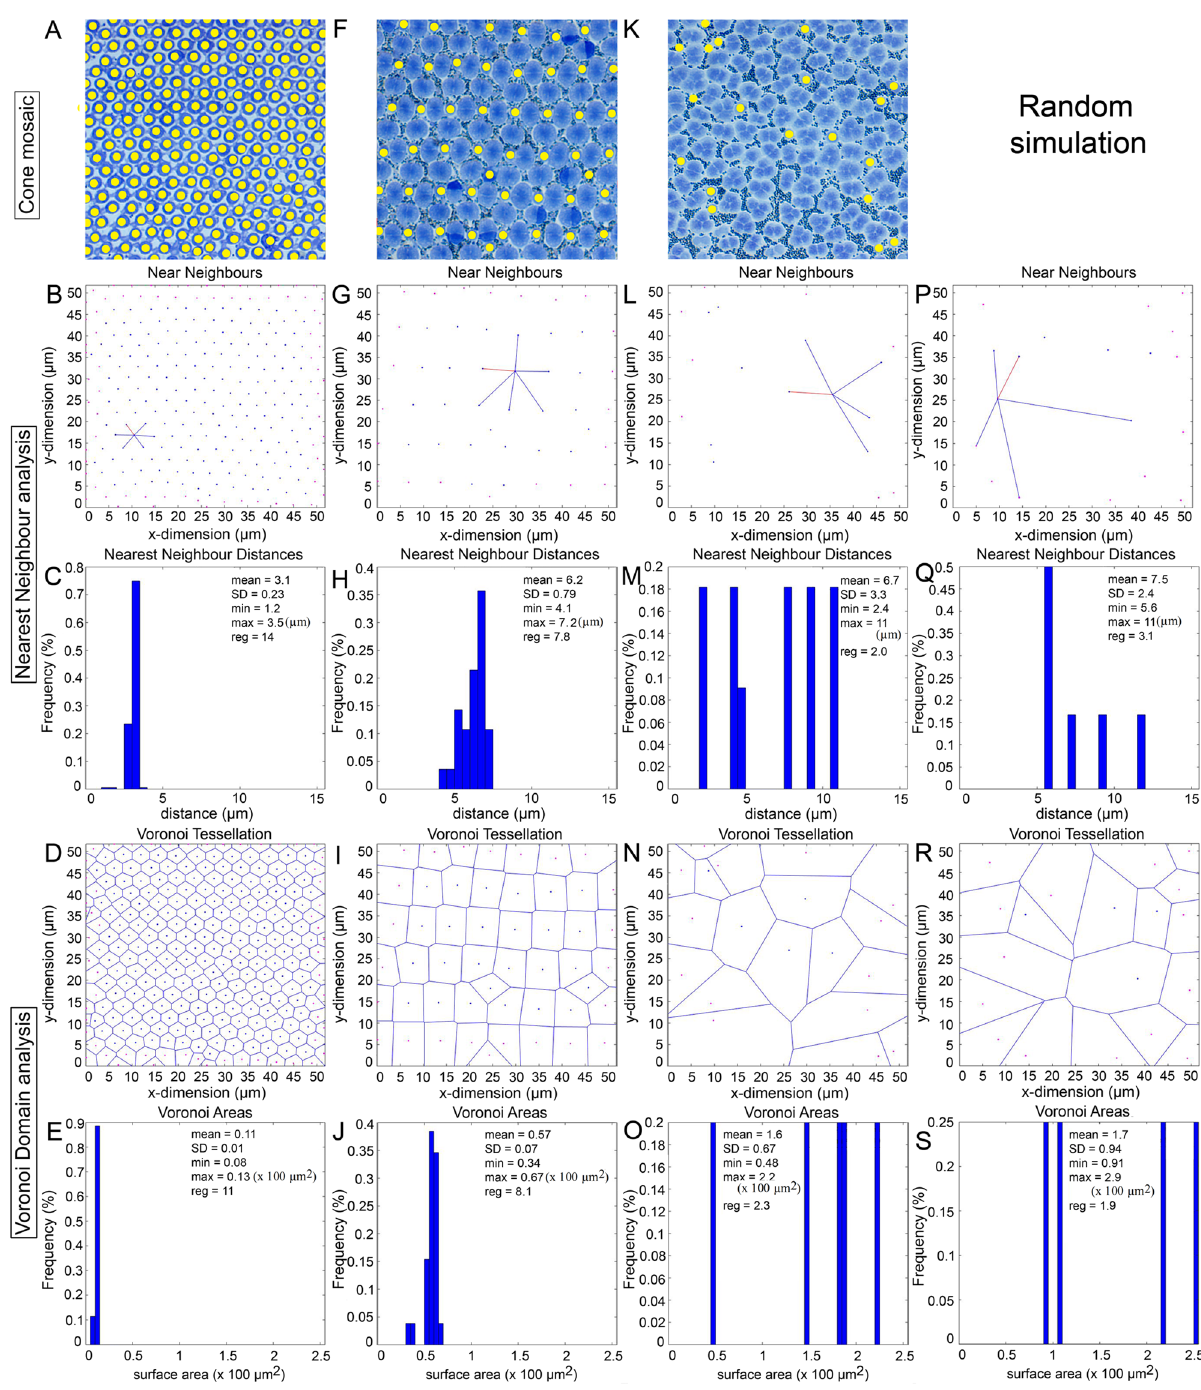
Figure 9. Spatial analysis of single cone distributions from representative mosaics in the retina of Atlantic halibut undergoing metamorphosis. Single cones are marked with yellow dots. ( A – E ) Cone mosaic from the centrodorsonasal retina at 773 ATU ( A ); Nearest neighbour analysis of double cone centroids, illustrating the near neighbours of a single cone, including its nearest neighbour in red ( B ) and their frequency distribution ( C ) [statistics (in µm) are the mean nearest neighbour distance, its standard deviation (SD), the minimum (min) and maximum (max) nearest neighbour distances, and the regularity index = mean/SD]; Voronoi tessellation of double cone domains ( D ) and their frequency distribution ( E ) [statistics (in 100 µm 2 ) are the mean area (domain), its standard deviation (SD), the minimum (min) and maximum (max) areas, and the regularity index = mean/SD]. ( F – J ) Same presentation of data as per ( A – E ) but for the centroventronasal retina at 878 ATU. ( K – O ) Same presentation of data as per ( A – E ) but for the centrodorsotemporal retina at 878 ATU. ( P – S ) Same presentation of data as per ( B – E ) but for a random distribution of points matched for density with that in ( K ) and constrained by single cone soma